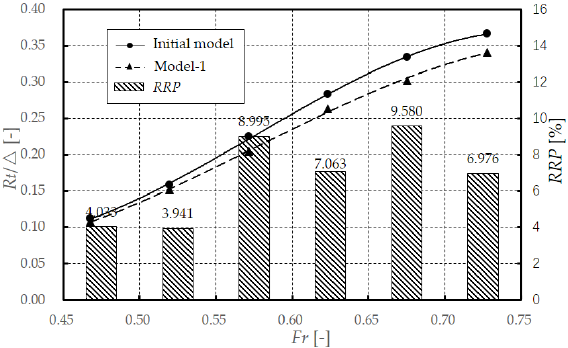
Figure 18. Comparison of resistance between the initial model and the Model-1.